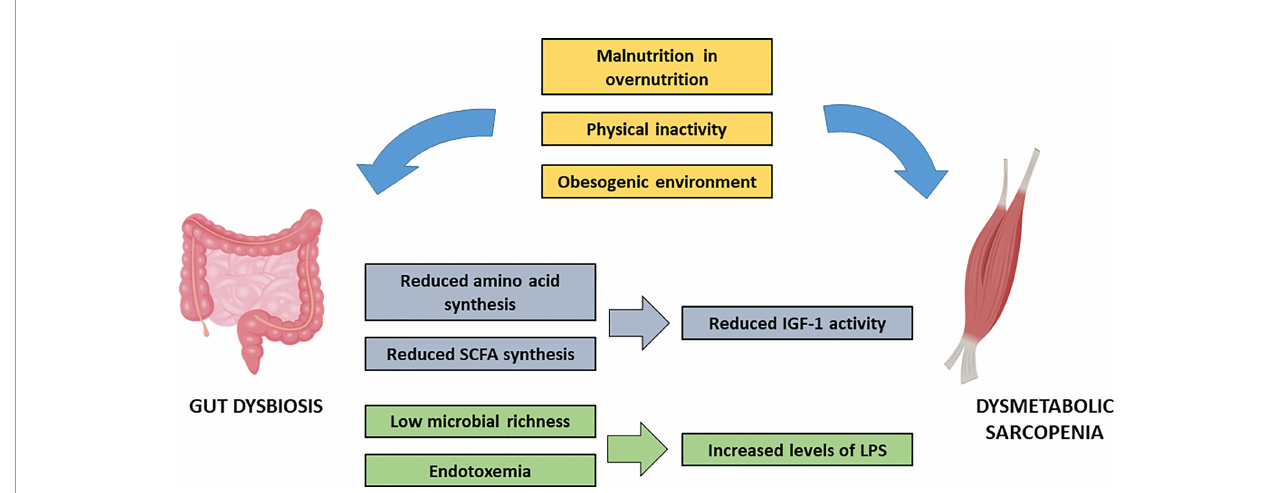
FIGURE 3 | Impact of environmental factors and gut insulin-resistance derived gut dysbiosis on sarcopenia. IFG-1, Insulin-like Growth Factor-1; LPS, lipopolysaccharide; SCFA, short chain fatty